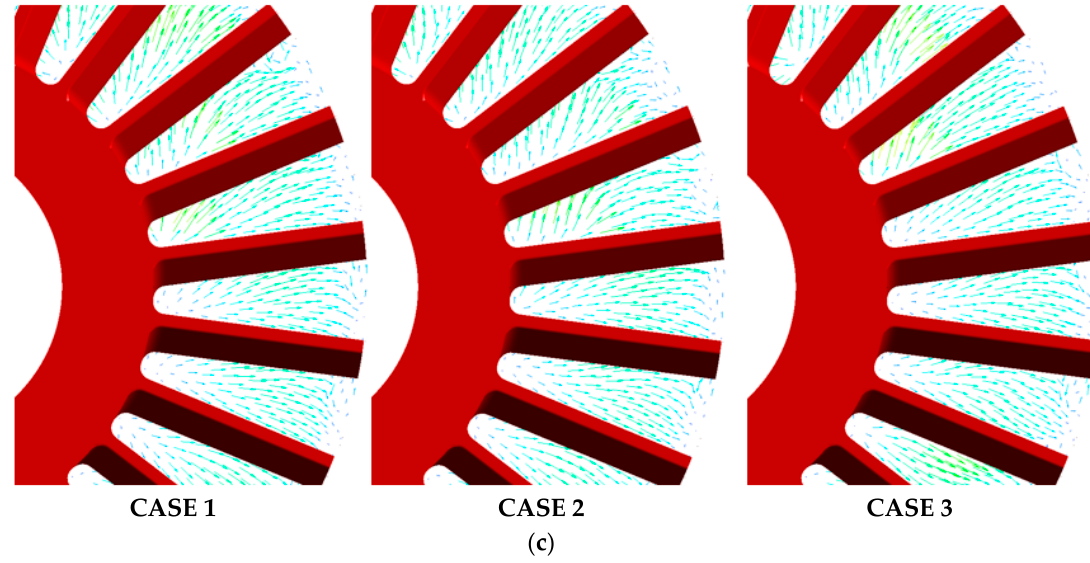
Figure 11. Velocity vector distribution in the impeller. ( a ) Plane 1; ( b ) Plane 2; and ( c ) Plane 3.